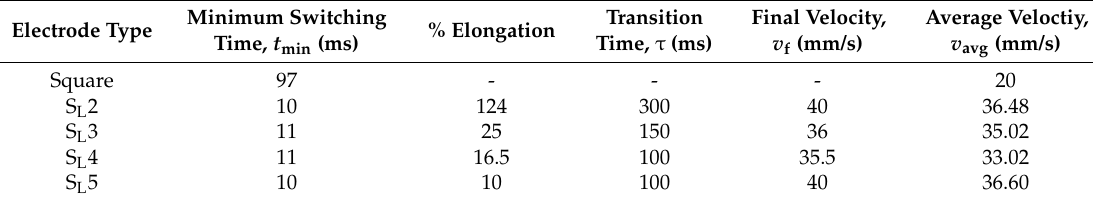
Table 1. Summary of experimental results.